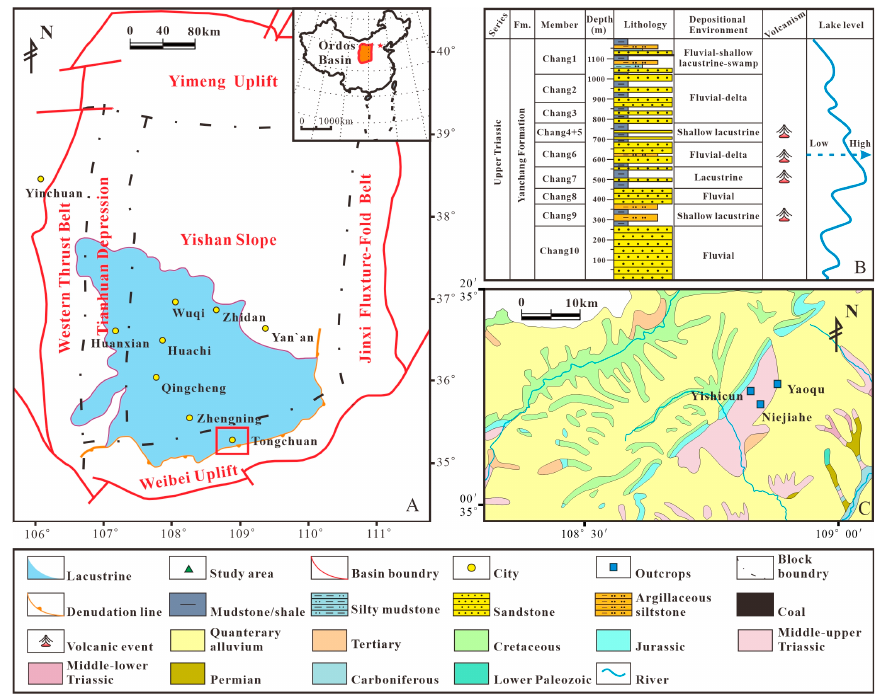
Figure 1. Regional tectonic zone ( A ), lithology ( B ) and study area ( C ) of the Ordos Basin. During the Indosinian movement, the North China plate, Yangtze plate, and Qinling block collided and merged with each other, and the Qinling-Dabie orogenic belt began to form, which resulted in the common absence of the Upper Triassic in the southern part of North China. The Yanchang Fm. is the strata with the highest surface exposure and the most complete preservation in the northern part of China, and it is also the source rock that first occurred when the basin became the inland lake basin [25]. The average thickness of the Yanchang Fm. is 1300 m, which is divided into 10 oil layer groups (from Chang 10 to Chang 1 Members) from bottom to top (Figure 1B). From the formation